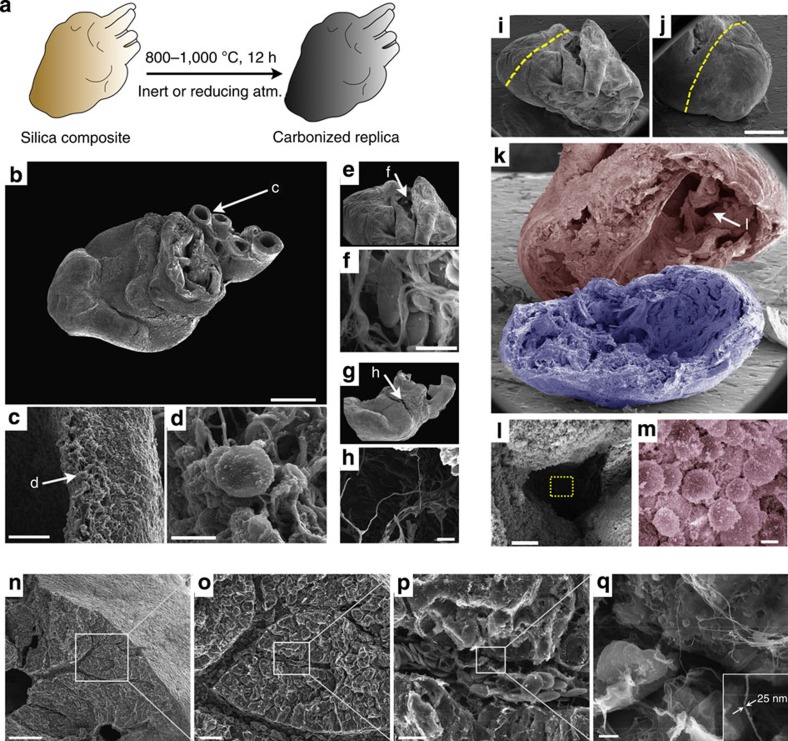
Shape-preserving conversion of silica bioreplication tissues into conductive specimens.(a) Schematic showing pyrolysis of a silicified heart into a carbonized silica replica. (b) SEM imaging (without conductive metal coating) of a heart carbonized at 1,000 °C (the background is subtracted for clarity; scale bar, 1 mm). (c,d) Show increasing magnification of an arterial wall (c, scale bar, 30 μm) and (d, scale bar, 5 μm) . (e) A crack in the top surface (indicated by arrow) reveals cellular and micro- (~1 μm) to nanoscale (~70 nm) extracellular fibres (f, scale bar, 5 μm). (g) A small opening in the side of the heart (indicated by arrow) reveals free-standing fibres and an interior chamber (h, scale bar, 10 μm). (i,j) Manual sectioning of a carbonized heart (dotted lines, j, scale bar, 1 mm) reveals the internal chambers (k). The two sections have been given false colour for clarity. Deep imaging into the area denoted by the arrow in k (l, scale bar, 50 μm) and further magnified (area in dashed rectangle in l) in m (scale bar, 5 μm) reveals surface bound cells ~1.5 mm within the tissue section (false coloured for clarity). (n–q) Increasing magnification of a sectioned carbonized liver shows internal vascularization and resolution of fibrous features (q, inset). (n–q) Scale bars, 250, 50, 10 and 1 μm, respectively.